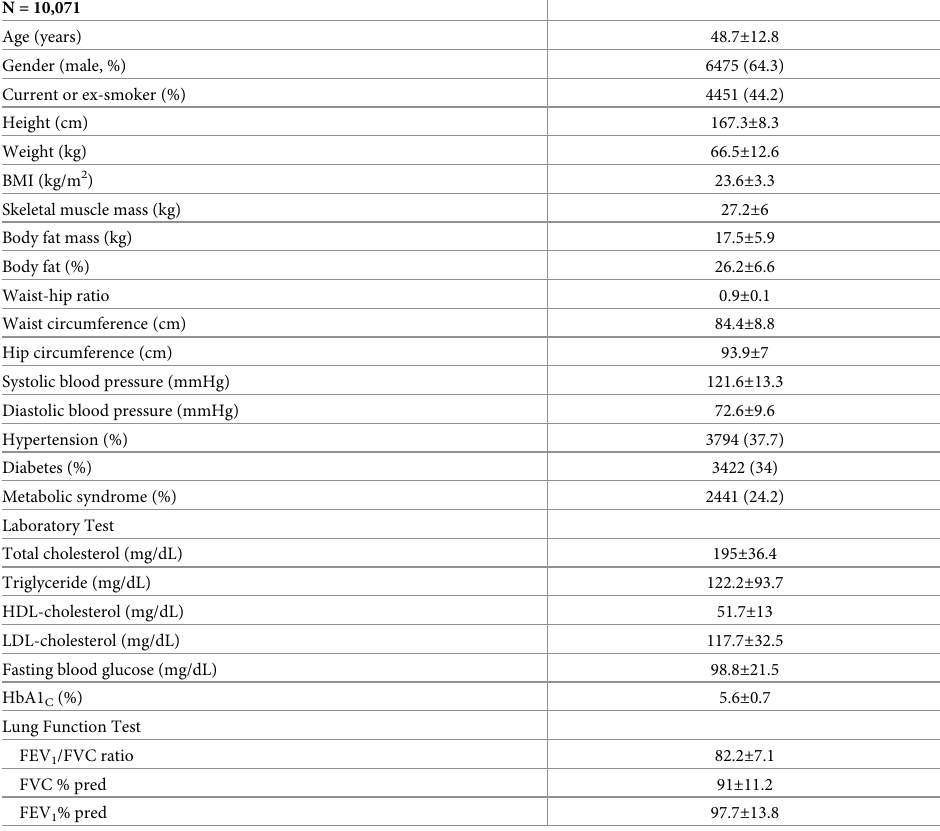
Table 1. Clinical characteristics of the study population.